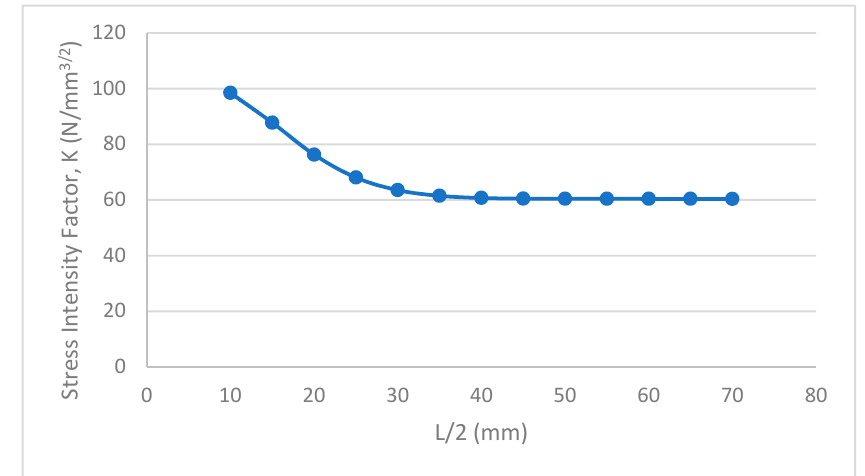
Figure 6. Convergence study to evaluate the optimum pipe length for the avoidance of load end-effects . Table 4. Comparison of SIF values using present method with [28] and [26] .